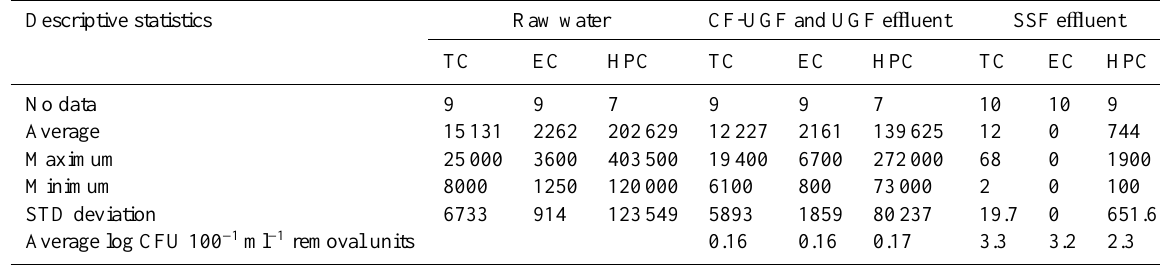
Table 6. Microbiological behaviour without the use of coagulant (UGF: V f = 1 . 0mh − 1 , SSF: V f = 0 . 30mh − 1 ). Descriptive statistics